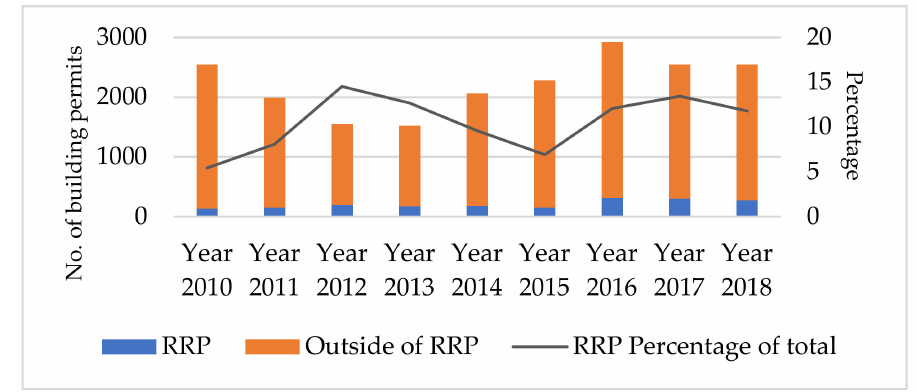
Figure 6. Percentage of RRP residential building permits out of the total (2010–2018). Source: Own elaboration, based on INE